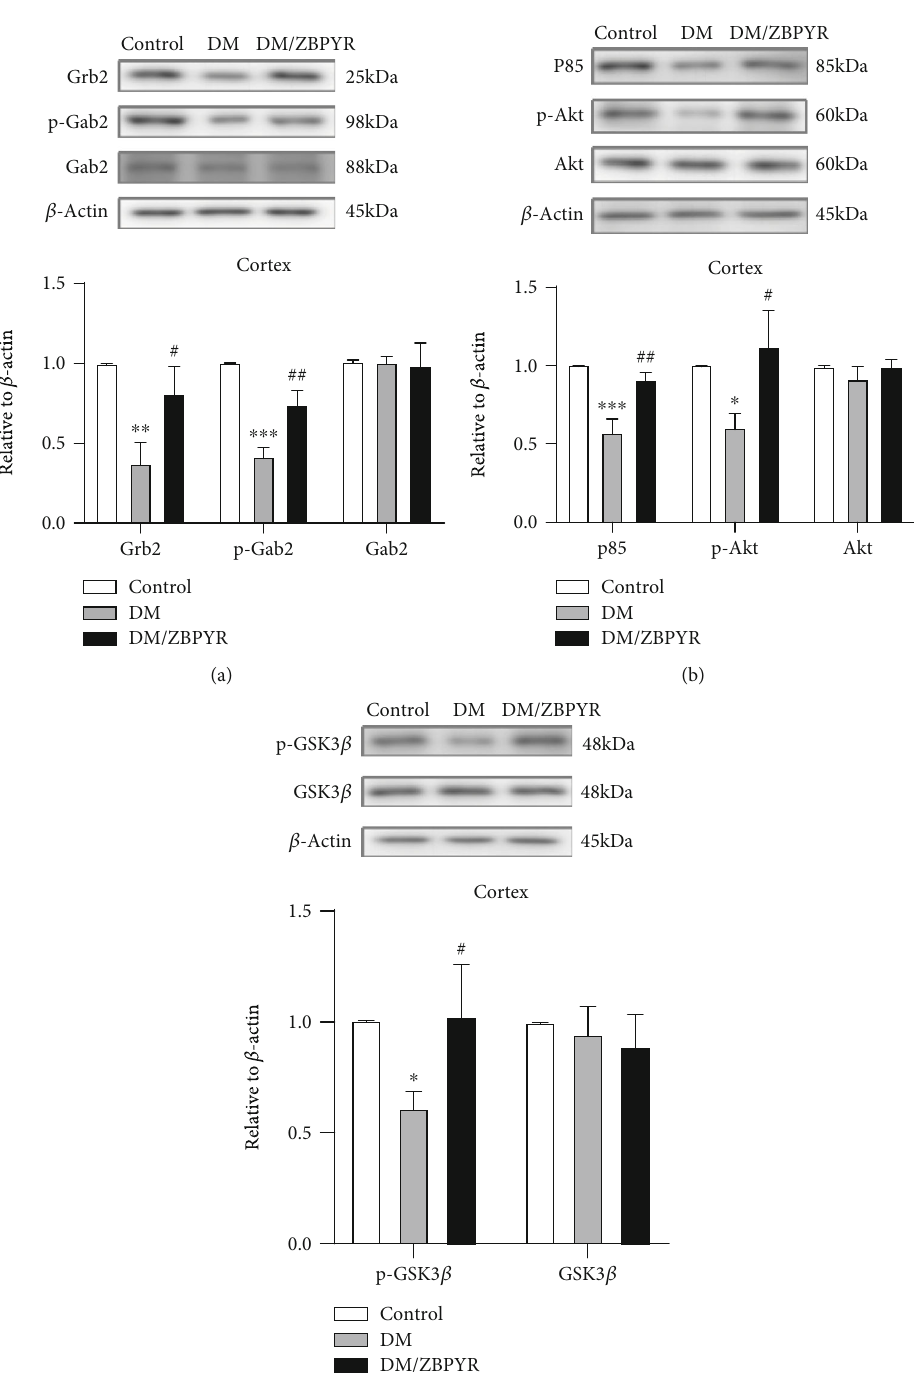
Figure 4: The e ff ect of ZBPYR on the expression of Grb2, Gab2, Akt, p-Akt, and Gsk3 β in mouse cerebral cortex. (a) The expression of Grb2 and p-Gab2 (Tyr452) in the cerebral cortex of DM mice was signi fi cantly reduced, and Grb2 and p-Gab2 (Tyr452) were increased to varying degrees after ZBPYR treatment. There were no statistically signi fi cant changes in the total levels of Gab2 and Akt in the three groups. (b) Compared with control mice, p-Akt (Ser473) expression in the cerebral cortex of DM mice was signi fi cantly reduced, while that of DM/ZBPYR mice was signi fi cantly increased. Compared with the DM group, p85 was signi fi cantly increased in the cerebral cortex of the DM/ZBPYR group. (c) The degree of Ser9 phosphorylation of GSK3 β in the cerebral cortex of the DM group was reduced to varying degrees, and the level of p-GSK3 β (Ser9) was increased in the cerebral cortex of the DM/ZBPYR group. Values are means ± S : D : from 3 mice in each group. ∗ p < 0 : 05 , ∗∗ p < 0 : 01 , and ∗∗∗ p < 0 : 01 compared to control; # p < 0 : 05 and ## p < 0 : 01 compared to